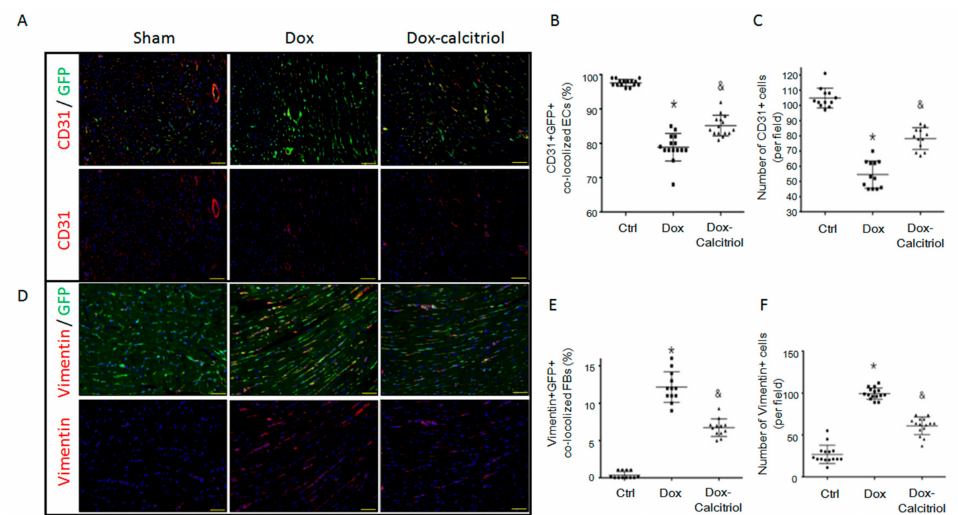
Figure 4. Calcitriol attenuated doxorubicin-induced endothelial-to-mesenchymal transition (EndMT) in the mouse model. ( A ) Representative photomicrographs of double immunofluorescence staining for the antibodies: CD31 (red) and GFP (green). ( B ) Quantification of CD31 + / GFP + cells per visual field in the Ctrl, Dox and Dox–calcitriol groups. ( C ) Representative photomicrographs of double immunofluorescence staining for the antibodies: CD31 (red). Quantification of CD31 + cells per visual field in the Ctrl, Dox, and Dox–calcitriol groups. ( D ) Representative photomicrographs of immunofluorescence staining for the antibodies: GFP (green) and vimentin (red). ( E ) Quantification of GFP + and Vimentin + cells per visual field in the Ctrl, Dox, and Dox–calcitriol groups. ( F ) Representative photomicrographs of double immunofluorescence staining for the antibodies: vimentin (red). Quantification of vimentin + cells per visual field in the Ctrl, Dox and Dox–calcitriol groups. n = 3 mice per group, (5 high power field (HPFs) per mouse, 15 HPFs total). Scale bar: 200 µ m; Data are expressed as mean ± SEM, and n represents the number of animals. * p < 0.05 vs. Ctrl, & p < 0.05 vs.